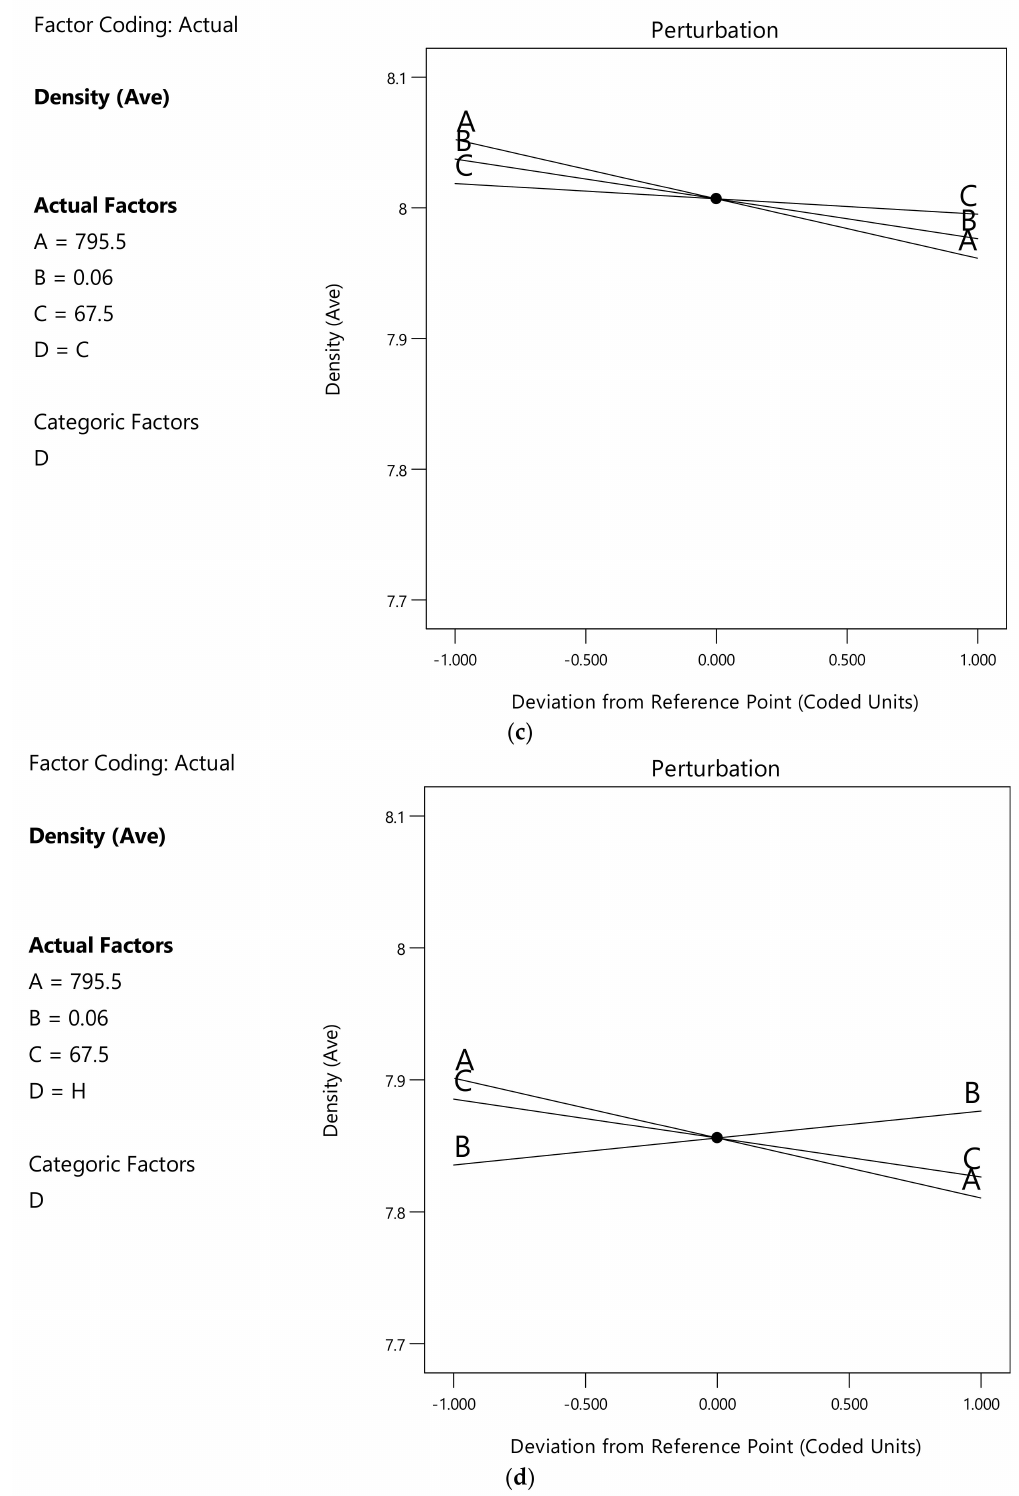
Figure 12. Influence of the scanning strategy on the density (g/cm 3 ) considering: ( a ) the scan pattern, ( b ) the process parameters and the stripes patten, ( c ) the process parameters and the chessboard pattern, ( d ) the process parameters and the hexagonal